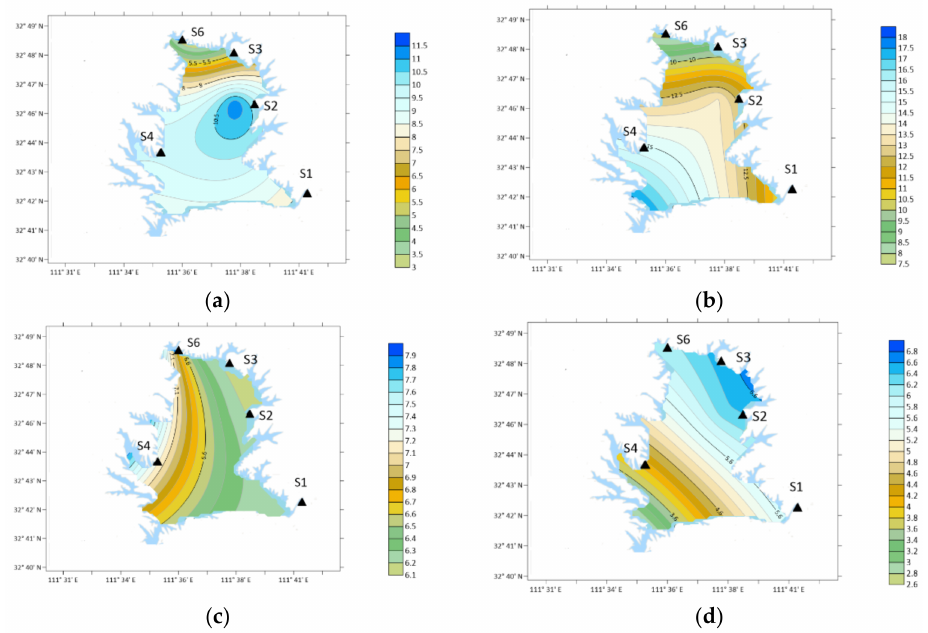
Figure 12. Spatial variation of NMA concentration. ( a ) Winter; ( b ) spring; ( c ) summer; ( d ) autumn. The concentration of NMA is the highest in S2 (Industrial Zone) in the southwest in winter. In spring and summer, the concentration was the highest at S6 (Forest Area). The concentration was the highest in S3 (Agricultural Area) in